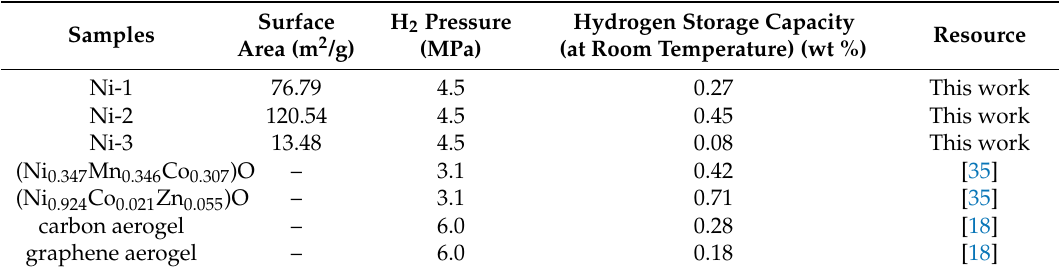
Table 3. The hydrogen storage capacity of nanoporous Ni with different surface areas and the hydrogen storage capacity of other similar porous materials